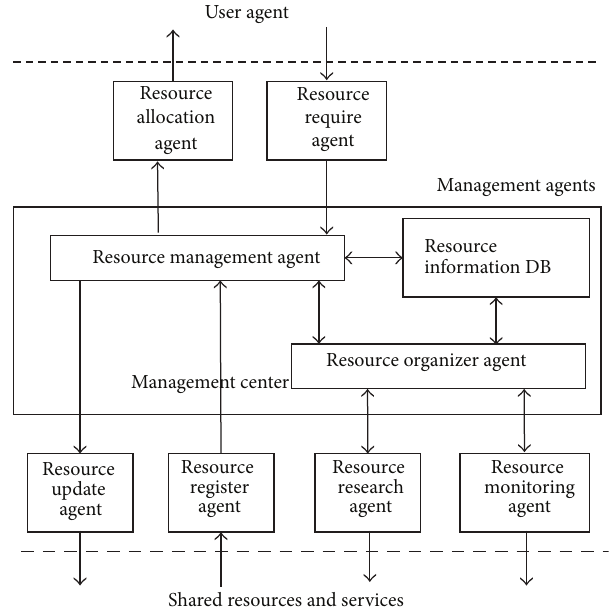
Figure 5: Virtual resource